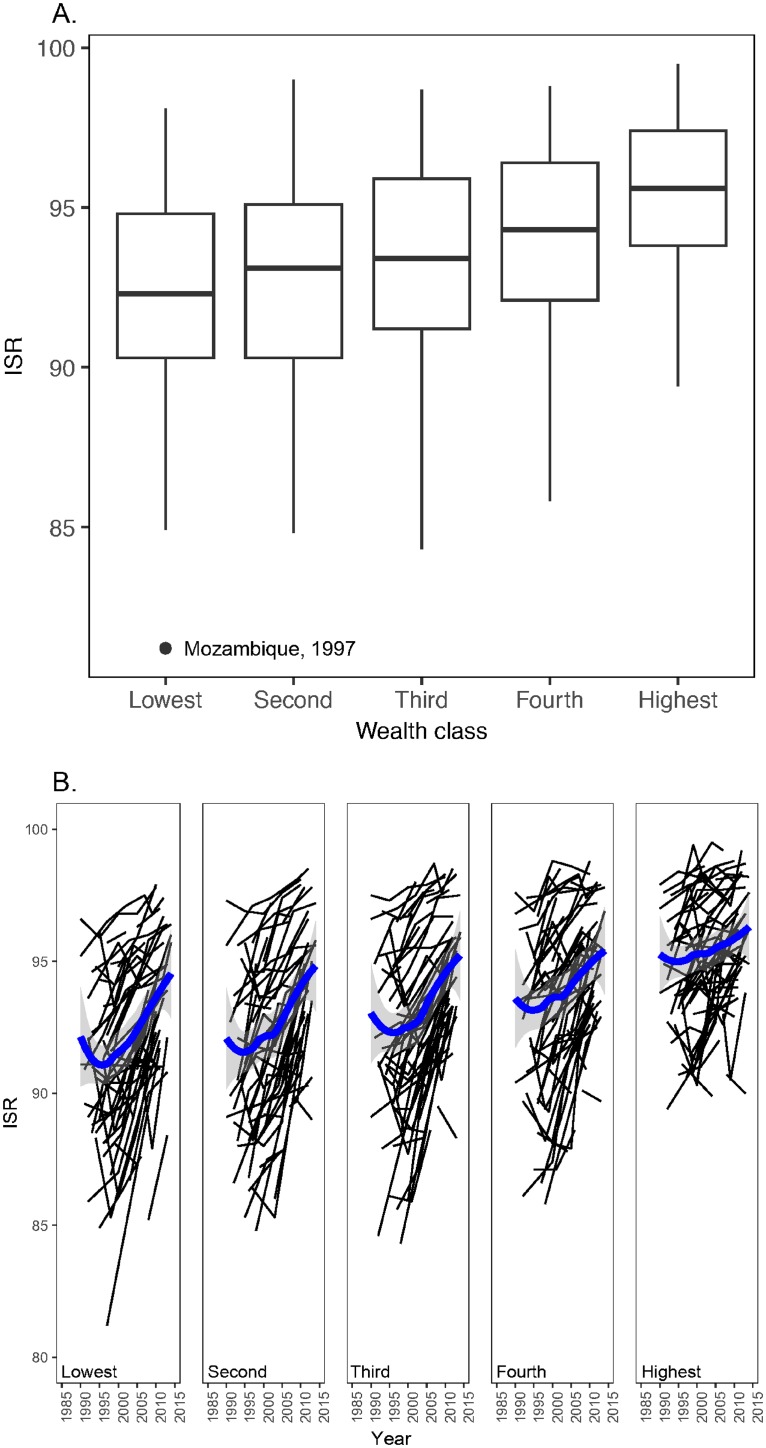
A. The boxplot summarizes the relation between ISR and relative wealth. For each of 72 developing countries, we obtained ISR values from 1990 to 2014 for the 5 wealth classes. For each wealth class, we combined the values across countries for the box plots (the sequence of medians from Lowest to Highest is: 92.3, 93.1, 93.4, 94.3 and 95.6). Using the medians for each country’s wealth classes, a Friedman test that accounts for the within country correlation showed a significant difference among wealth classes (χ2 = 161.85 on 4 degrees of freedom, p < 0.0001). Similar results were obtained when using mean ISR instead of median ISR. The outlier had no effect on these results. B. Trends in ISR values between 1990 and 2014 in the five wealth classes. Each thin line is a single country; the thick lines were fitted by local regression.